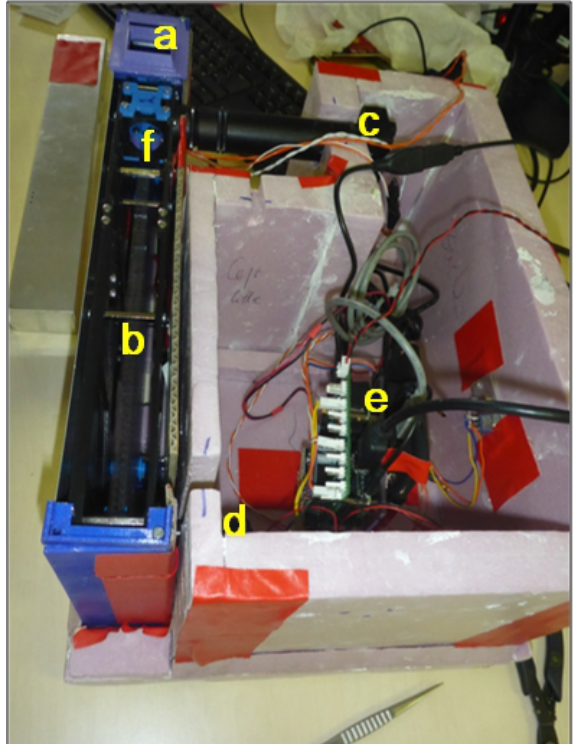
Figure 1. Top view on the open in situ imager B-ICI. (a) Inlet where particles enter during measurement; (b) oil-coated moving film; (c) CCD camera with an objective takes grey-map pictures ev- ery 1s; (d) motor which moves the film; (e) computer and battery; (f) LED to illuminate the